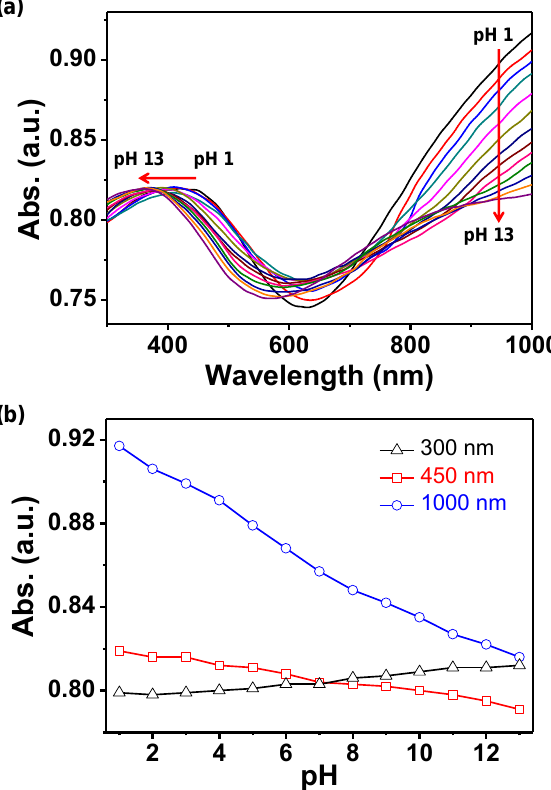
Figure 2. ( a ) Ultra-violet visible and near infra-red (UV-vis-NIR) absorption spectra of polypyrrole nanoparticles (PPyNPs) at different pH values. ( b ) Normalized absorption spectra of PPyNPs with a change in pH at different wavelengths (black for 300 nm, red for 450 nm, and blue for 1000 nm). Raman spectroscopy was performed to characterize the di ff erent chemical states of the